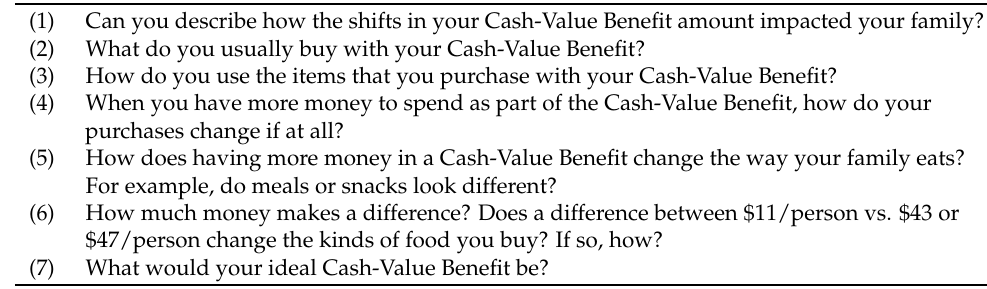
Table 1. Representative Interview